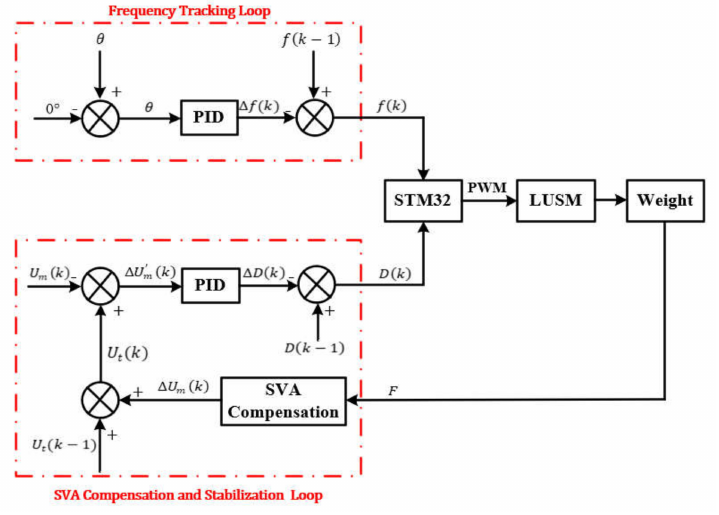
Figure 5. Control architecture of the proposed